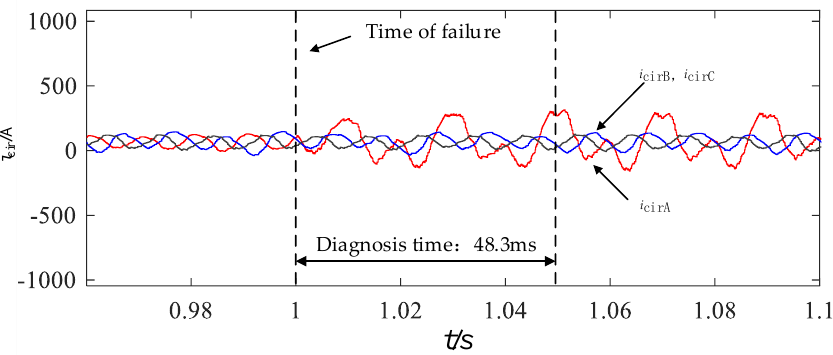
short-circuit fault occurred at 1 s, and after the fault occurred, the fault classification was completed at 1.0483 s, taking 48.3 ms.